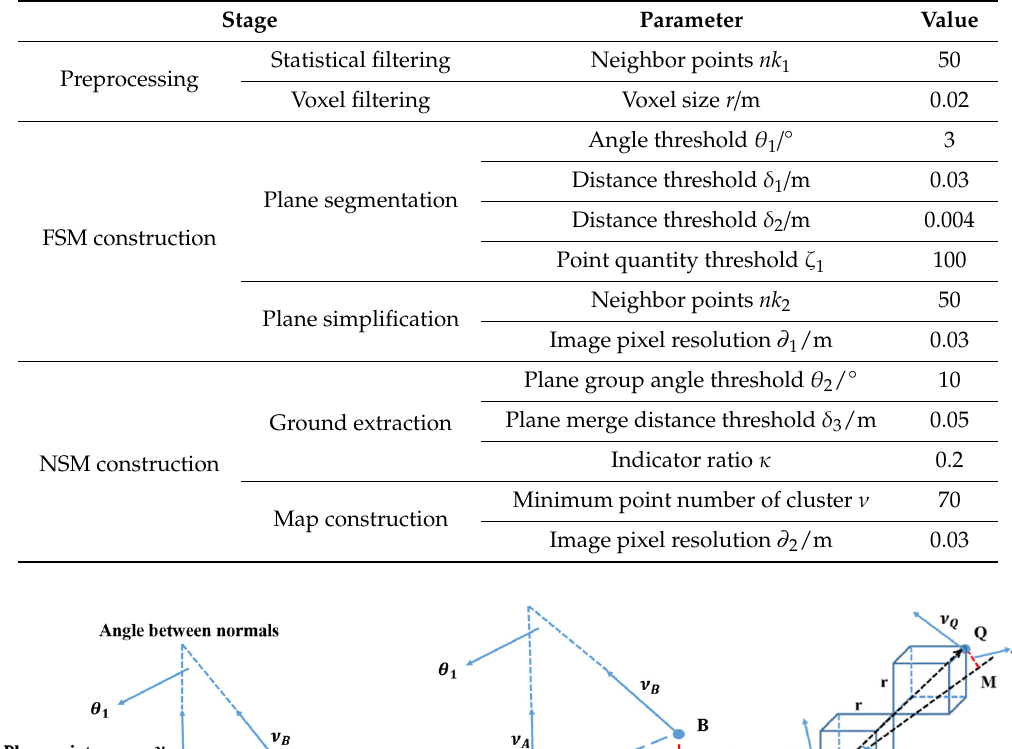
Table 1. Overview of parameters in proposed method. Figure 17. Experimental datasets: ( a ) simulation dataset 1, ( b ) simulation dataset 2, ( c ) real dataset 1, ( d ) real dataset 2, ( e ) real dataset 3, and ( f ) real dataset 4.